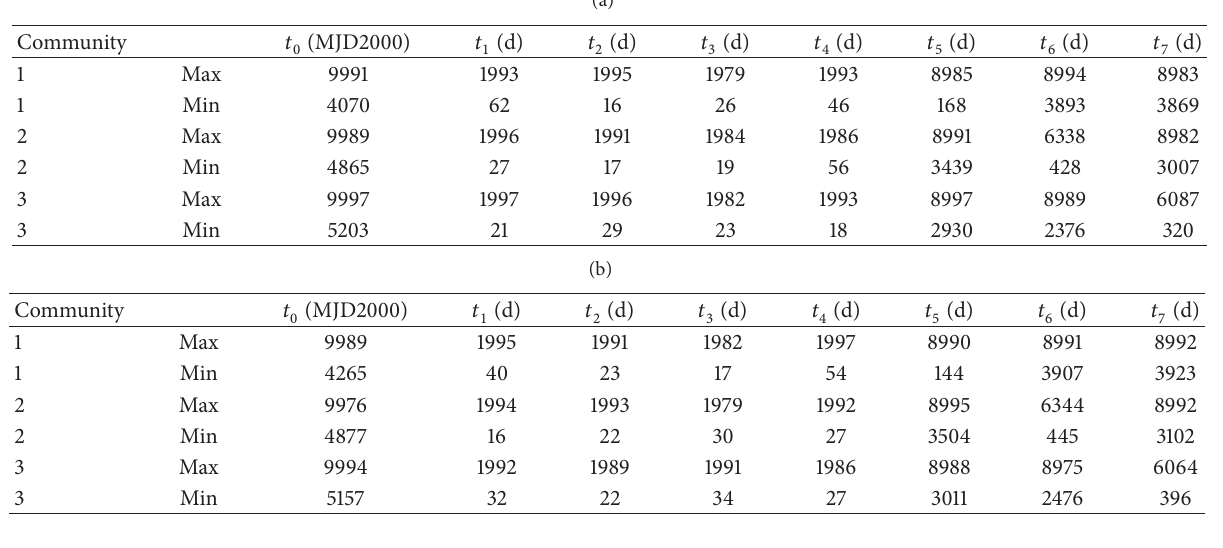
Table 5: The spatial range of each community in GTOC1.